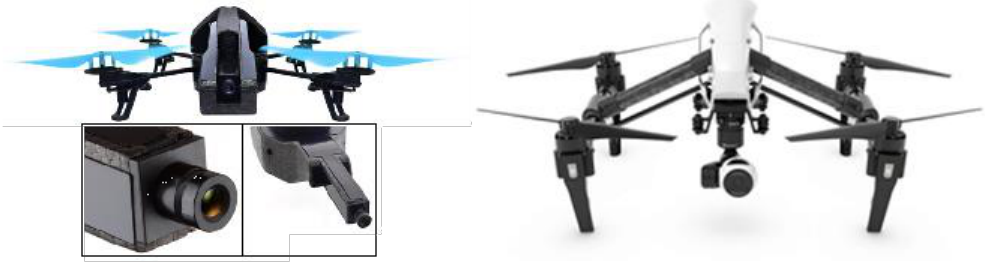
Figure 2. Commercial drones with on-board cameras: Parrot AR.Drone 2.0 (Parrot, Paris, France) ( left ) and DJI Inspire 1 (DJI, Shenzhen, China) ( right ). Table 1. Examples of commercial drones with on-board